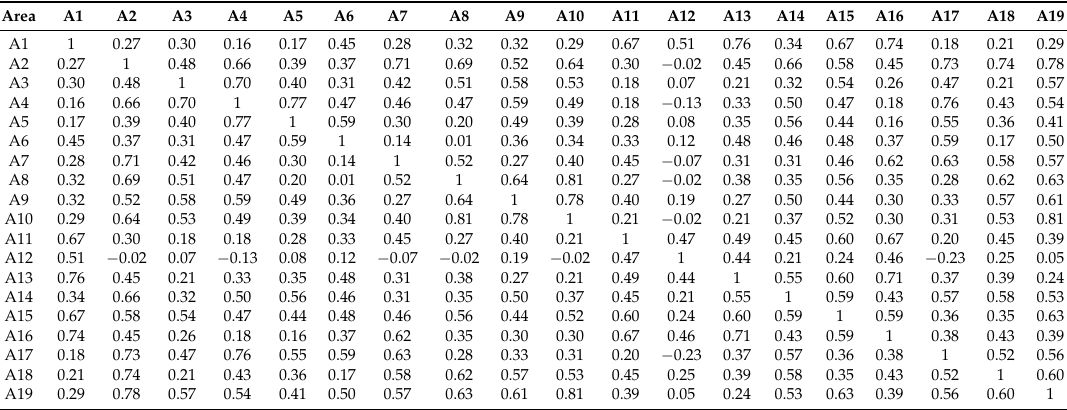
Table 16. Correlations between log losses in adjacent areas in Example